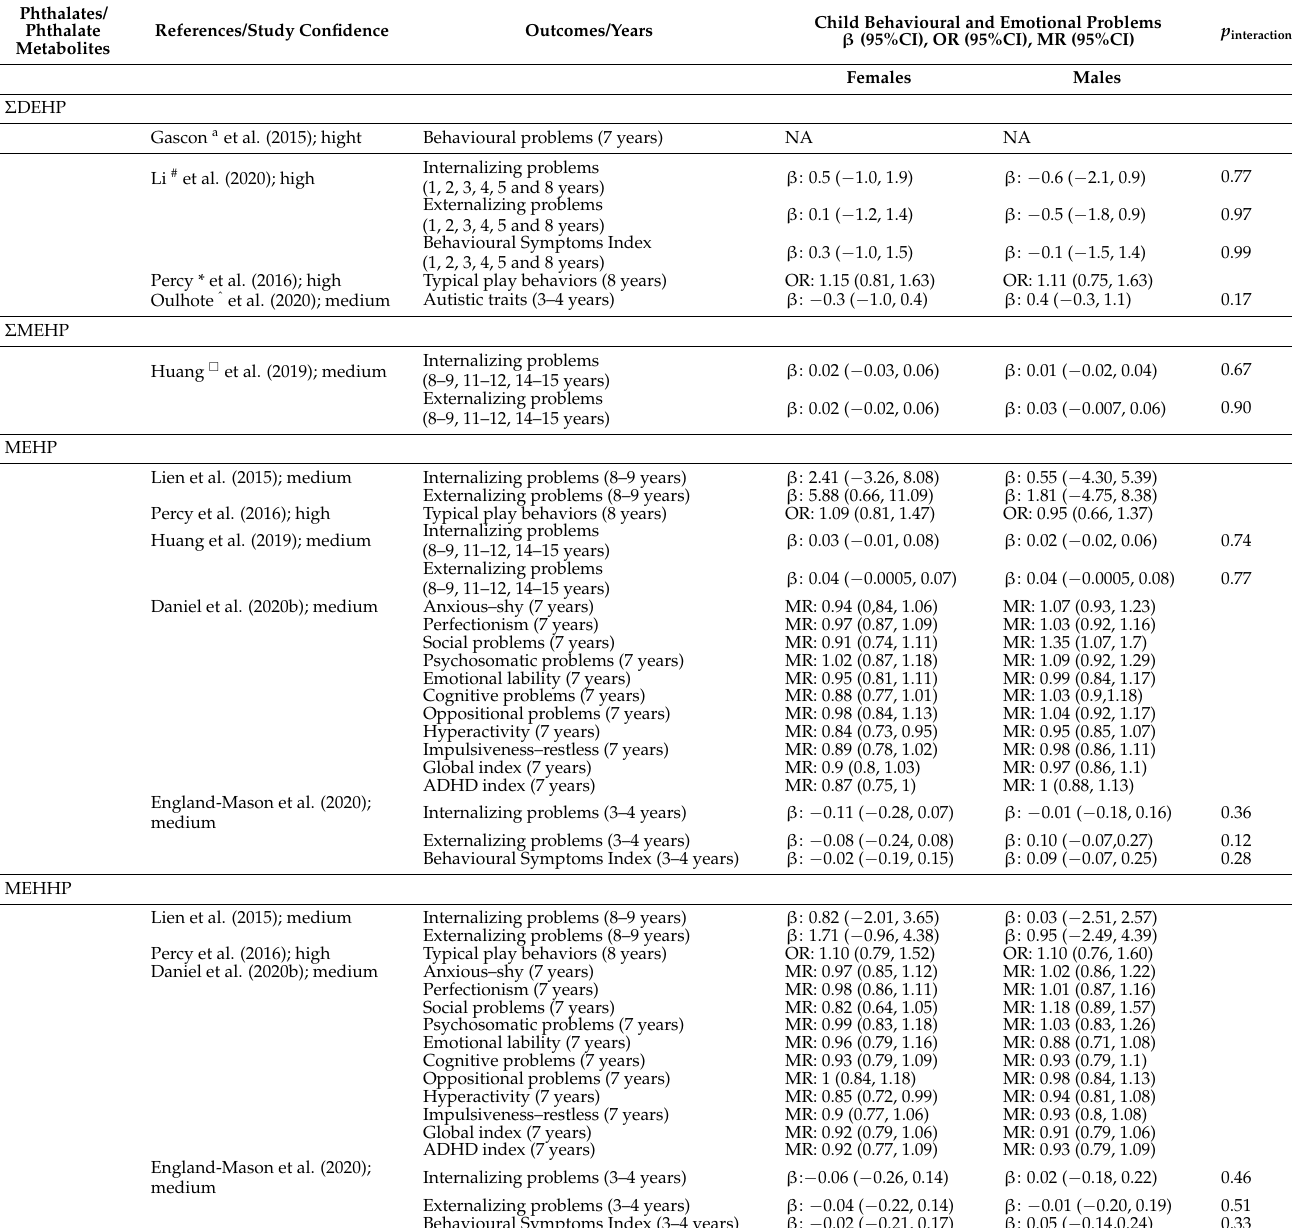
Table 5. Sex-specific differences between phthalates exposure and child behavioural and emotional problems. Phthalates/ Phthalate References/Study Metabolites